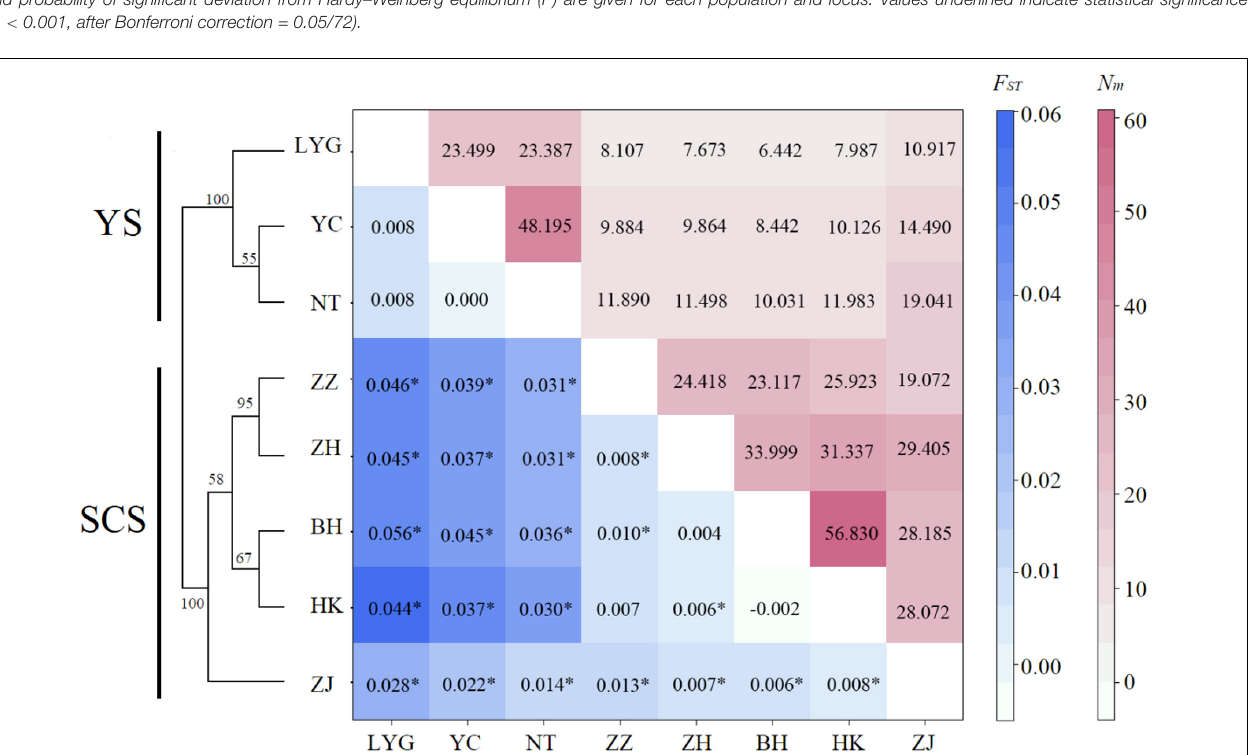
Figure 2 ). Samples from the YS formed one basal cluster and another cluster consisted of samples from the SCS. However, ZJ was clearly differentiated from the other four SCS